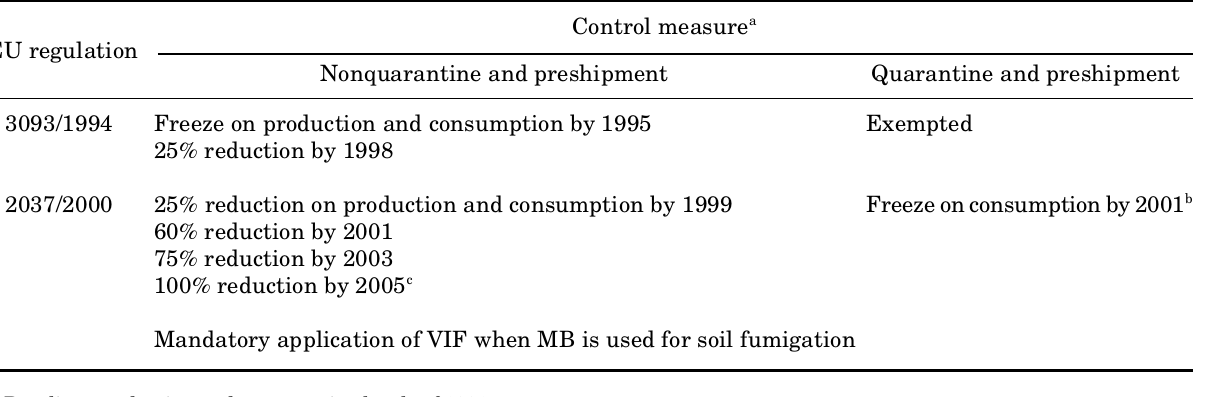
Table 2. Methyl bromide production and use phaseout schedules under the EU Regulations 3093/1994 and 2037/ 2000 (Gullino et al .,